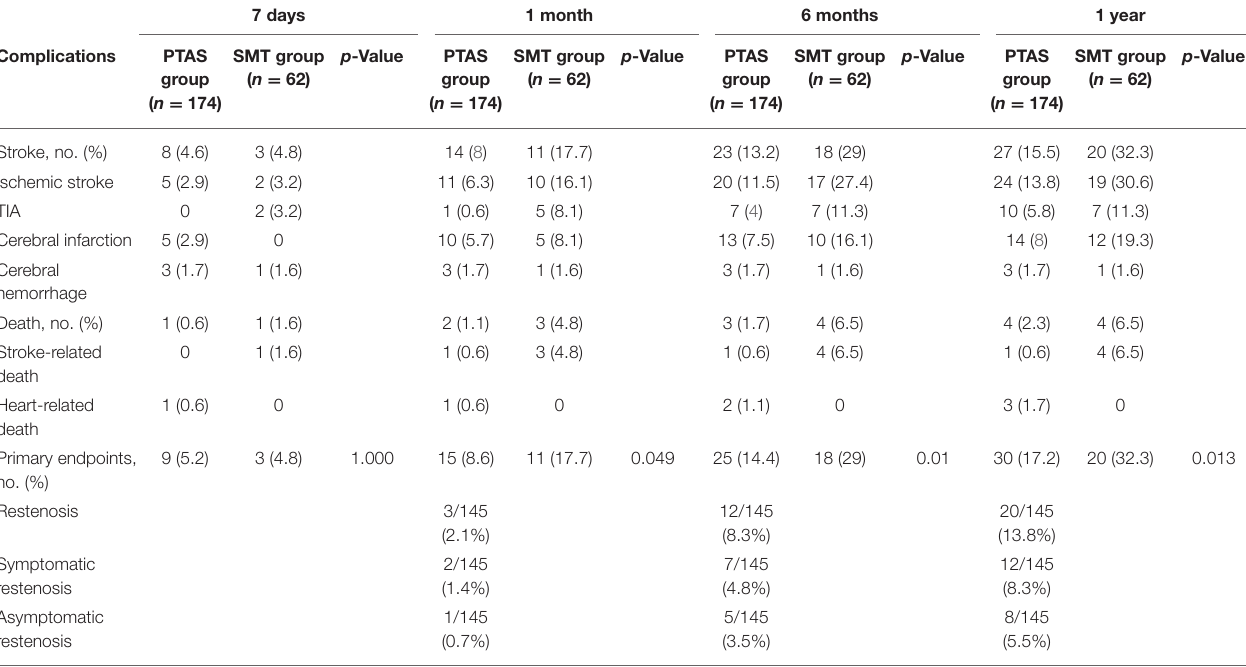
TABLE 3 | Primary endpoints at 7 days, 1, 6 months, and 1